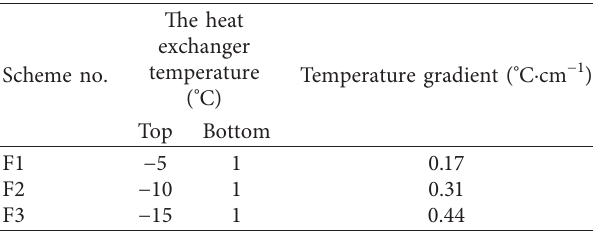
Figure 1: Schematic diagram of the unidirectional freezing test. Table 3: Freezing temperature gradients and corresponding temperature